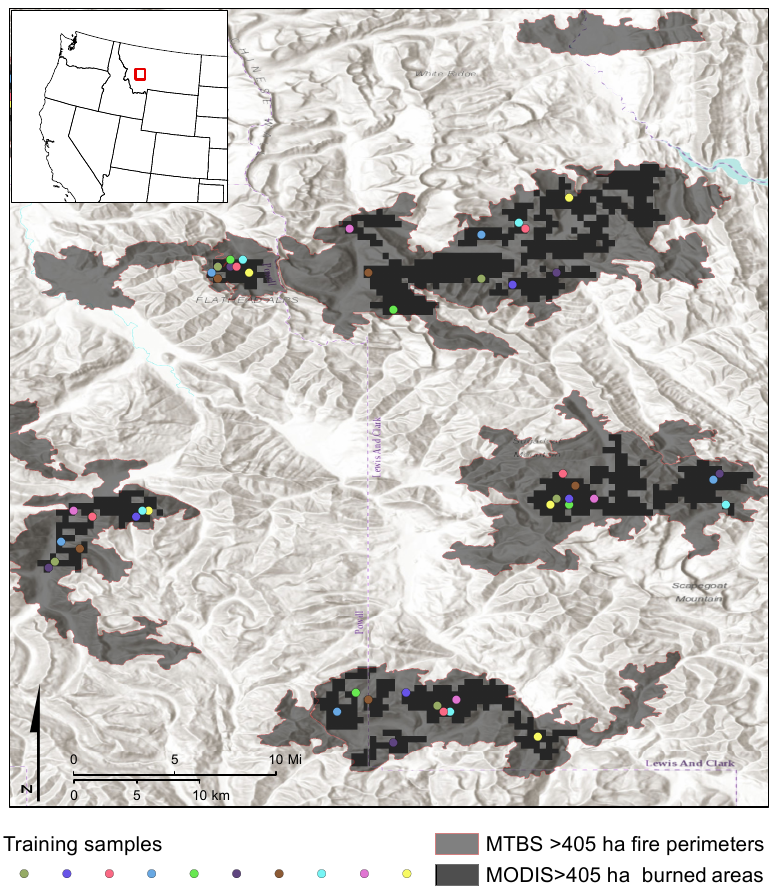
Figure 2. Example of how the Moderate Resolution Imaging Spectroradiometer (MODIS) burned area (BA) dataset was used to draw 10 random samples from within large fires. Each sample, taken across all large fires in 2005–2014, was used to train a random forest model to predict large fire probability. Fire perimeters from the Monitoring Trends in Burn Severity (MTBS) dataset are included because they were used to restrict BA sampling within individual wildfires (excluding prescribed